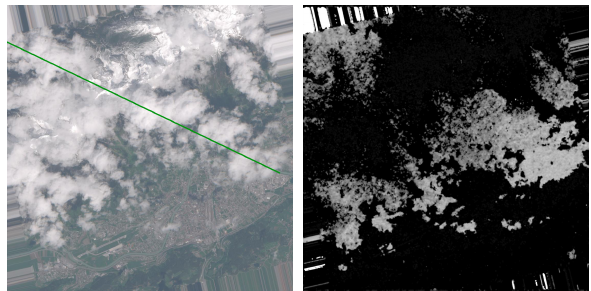
Figure 15. Test area Inb at Innsbruck, 10 × 10 km 2 , the green line represents the position of the profile line used in fig. 16 Fig. 16 shows the profiles of the resulting cloud DEM with heights above ground in green, the SRTM DEM in red and the sum of both – the absolute height of the clouds – in blue. It can clearly be seen, that the derived cloud-heights are really heights above ground since adding the ground-DEM gives a nearly con- stant cloud-height at 2000 to 2500 m with no clouds at the tops of higher mountains.